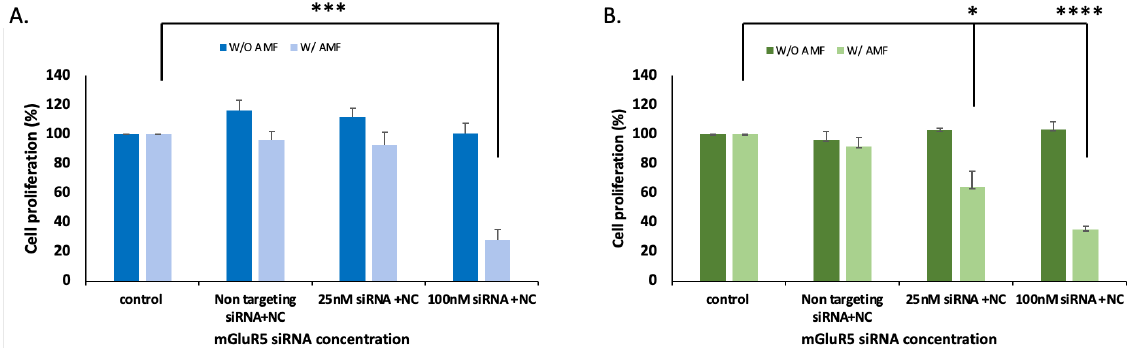
Figure 4. The proliferation ( A ) LM7 human metastatic osteosarcoma cells and ( B ) OS482 mouse metastatic osteosarcoma cells with and without AMF application (445 kHz) was measured by MTT assay. when 100 nM of mGluR5 siRNA was loaded to IO-nanocages and delivered under the AMFs, the cell proliferation was significantly decreased in both cell lines. * p < 0.05, *** p < 0.001, **** p < 0.0001, N = 3.